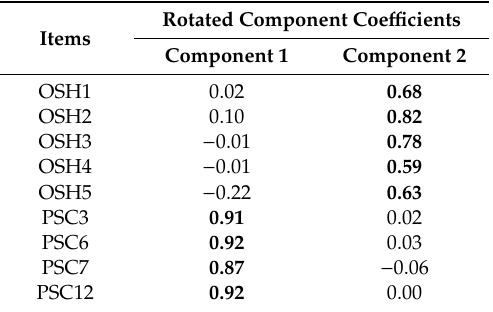
Note. Major loadings for each item are bolded.